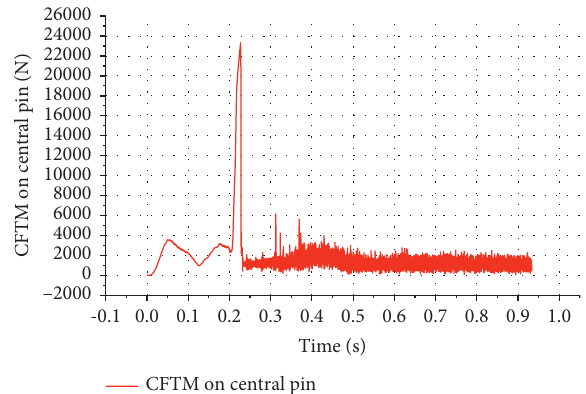
Figure 33: Emergency breaking load of intermediate connection point—course of